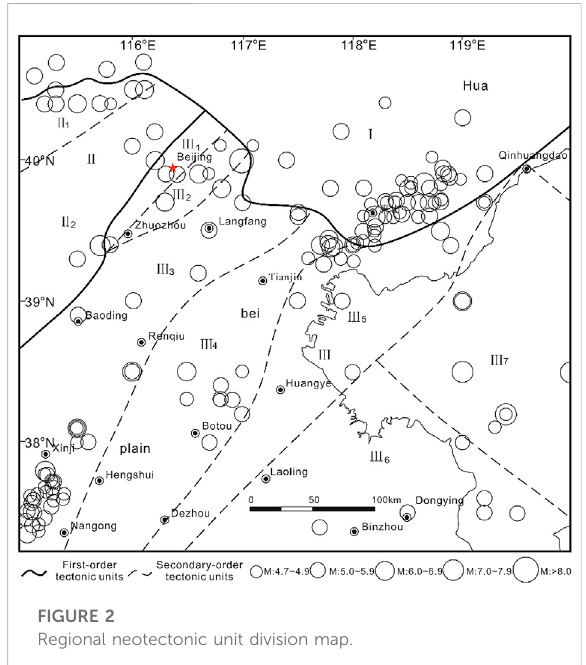
FIGURE 2 Regional neotectonic unit division